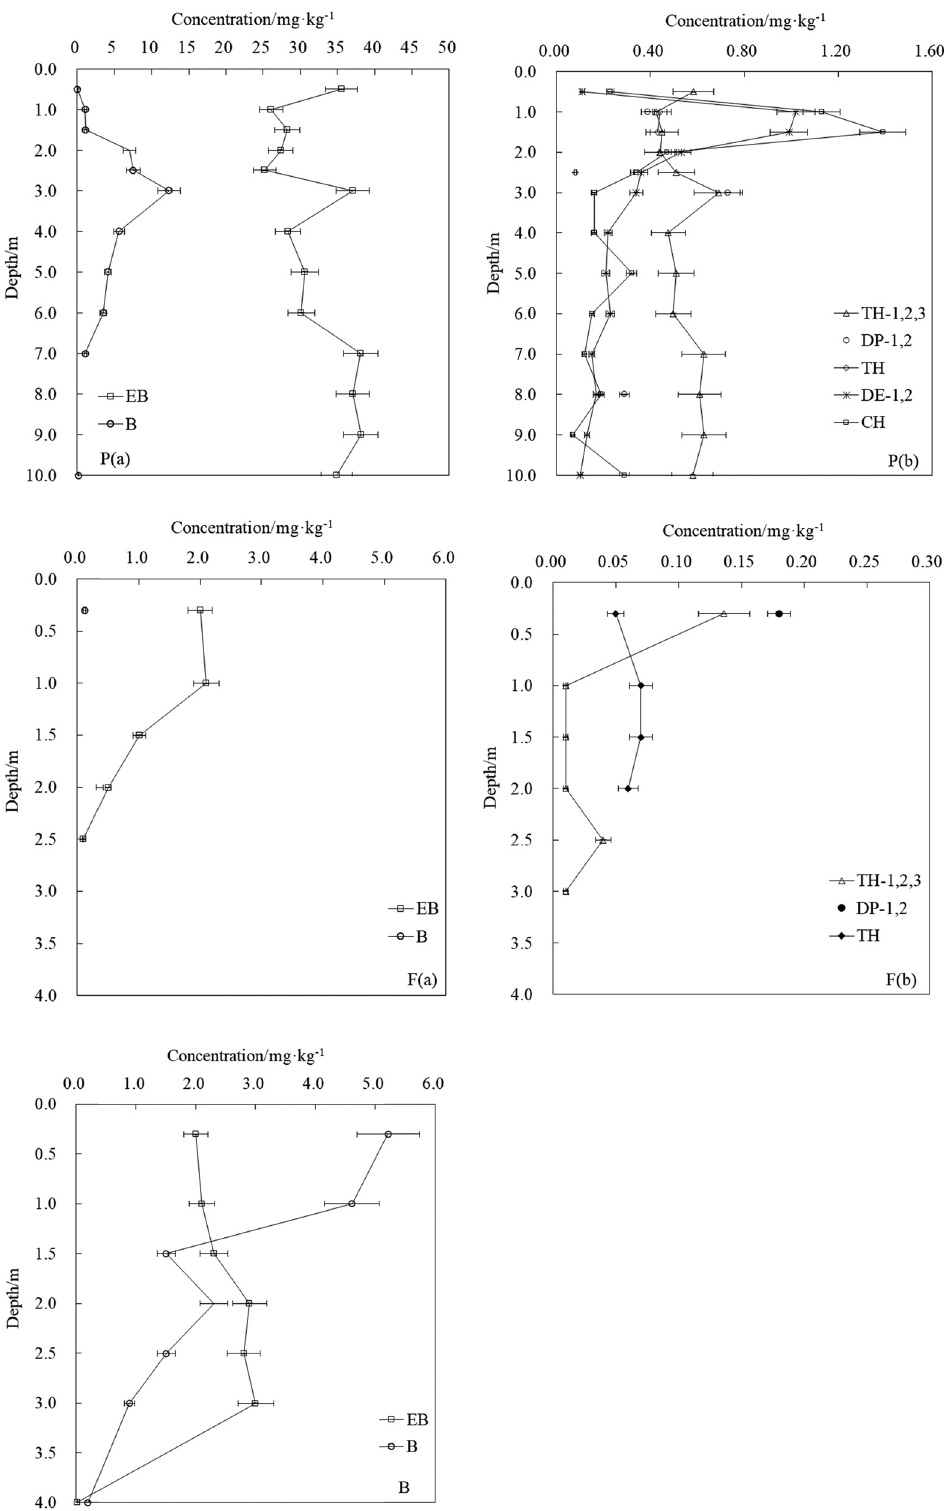
Figure 3: Vertical distribution of VOCs at di ff erent depths of the chemical site soil. ( P ( a ) and P ( b ) both for the pesticide production area, F ( a ) and F ( b ) both for the food additive production area, and ( B ) for the benzene puri fi cation and storage area )